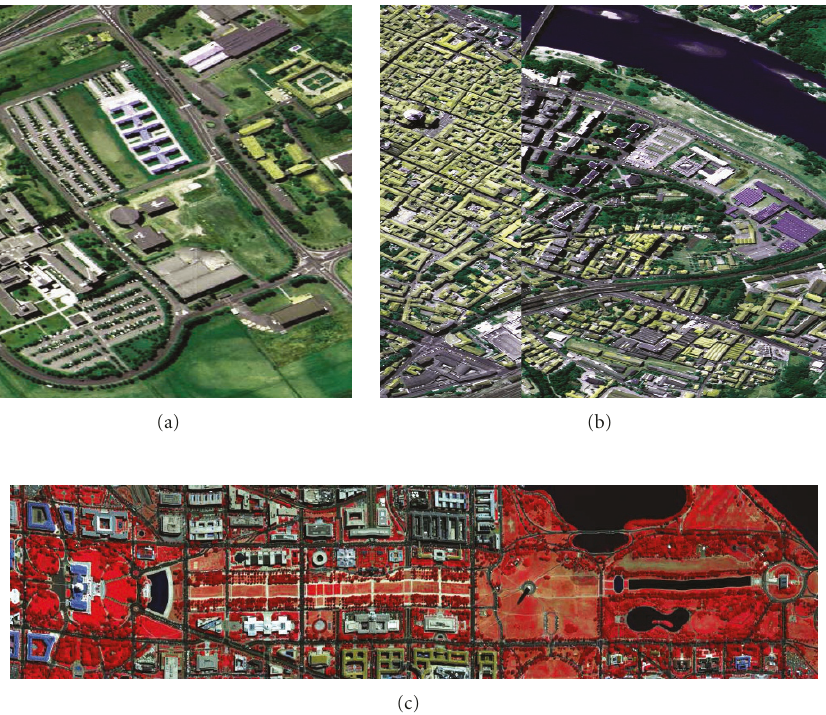
Figure 4: ROSIS data. (a) University Area, (b) Pavia Center. HYDICE data: (c) Washington